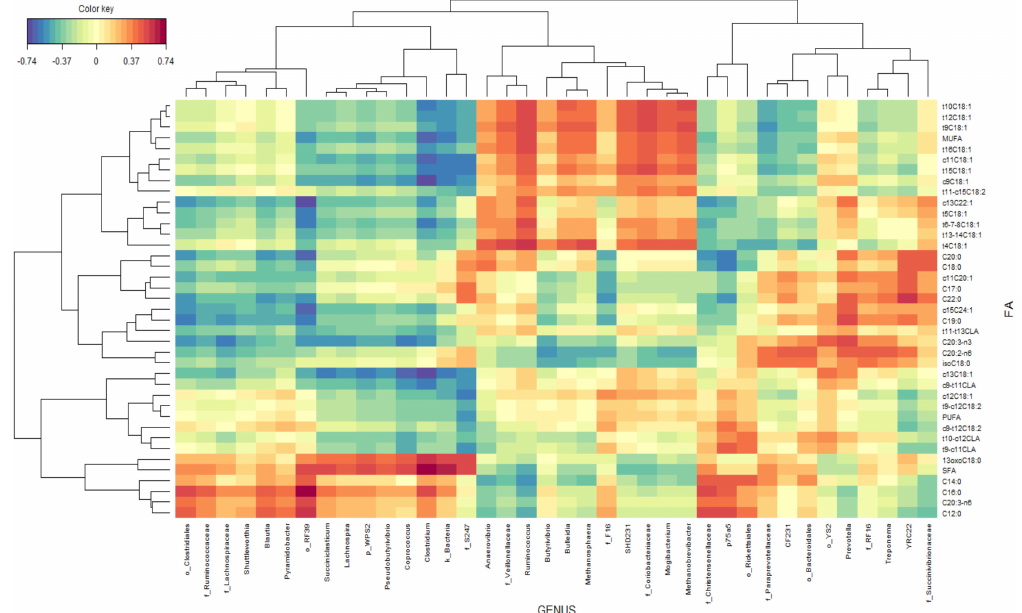
Figure 5. Associations between bacterial genus and ruminal fatty acid proportions independent of the experimental group. Clustered image map based on the regularized canonical correlations between bacterial relative abundances at the genus level and ruminal proportions of fatty acids. Significative correlations are colored following the key